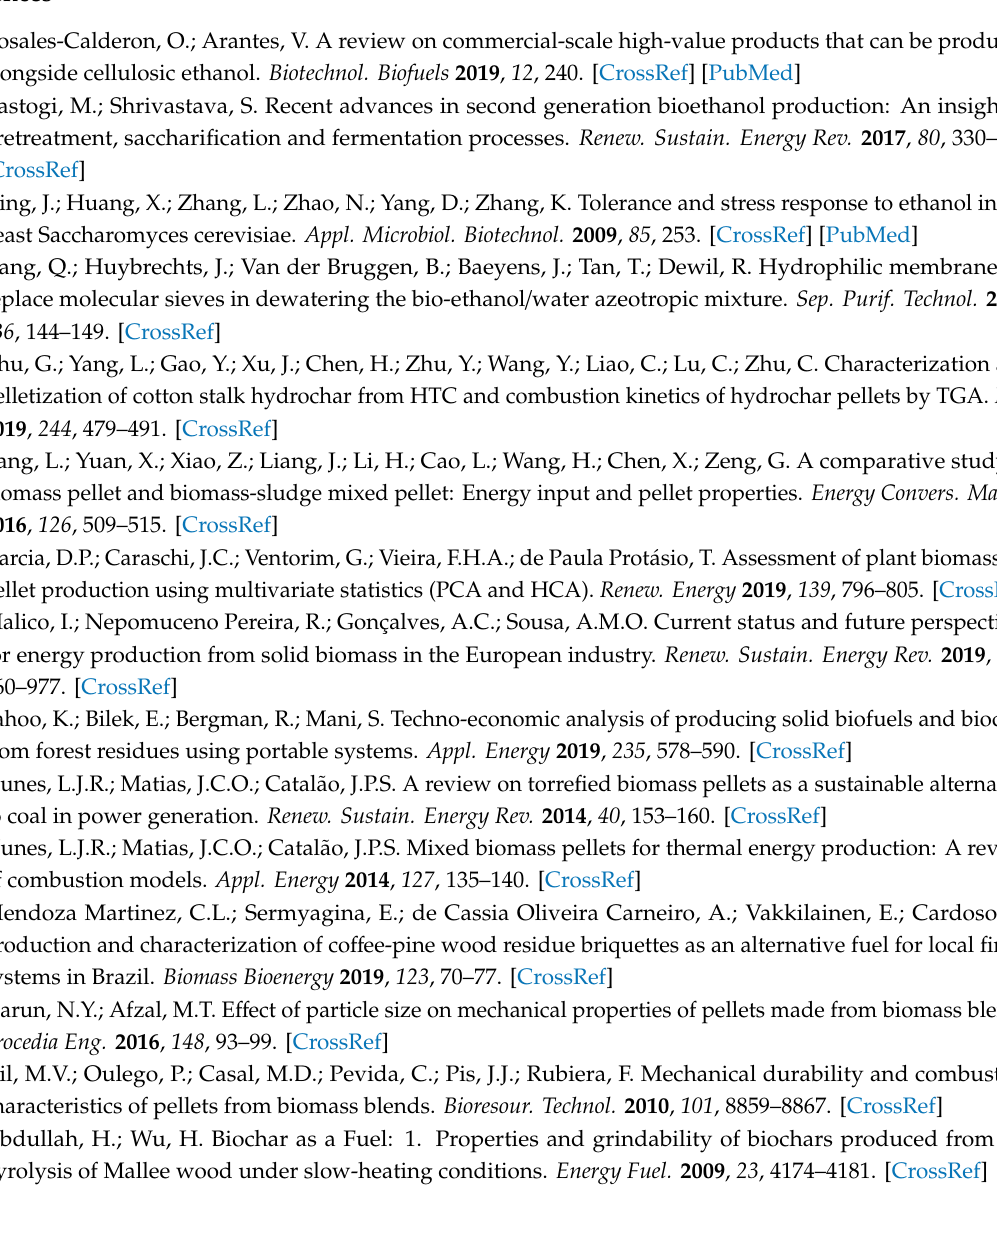
Supplementary Materials: The following are available online, Table S1: Descriptive analysis for the relative potential of the residual biomass as an alternative non-woody biomass waste to develop fuel pellets for heating and power, Table S2: Technical specifications of integrated set for pelleting, Table S3: Norms for the characterization of the starting